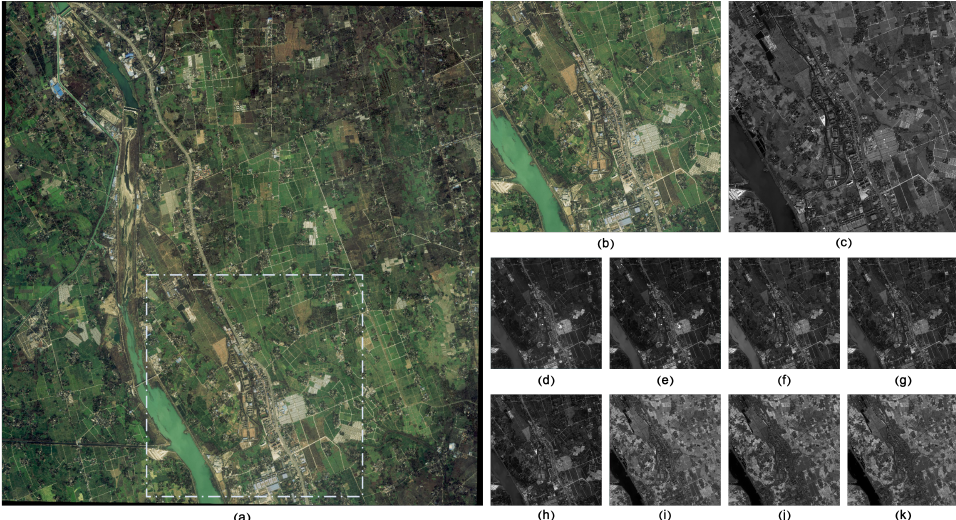
Figure 8. Overview of the Chongzhou dataset area from ( a ) the whole area of the Chongzhou data, the box is the sub-area of the display; ( b ) RGB-pansharpening image of sub-area; ( c ) panchromatic band image of sub-area; ( d ) coastal blue band image of sub-area; ( e ) blue band image of sub-area; ( f ) green band image of sub-area; ( g ) yellow band image of sub-area; ( h ) red band image of sub-area; ( i ) red edge band image of sub-area; ( j ) near-IR1 band image of sub-area; ( k ) near-IR2 band image of